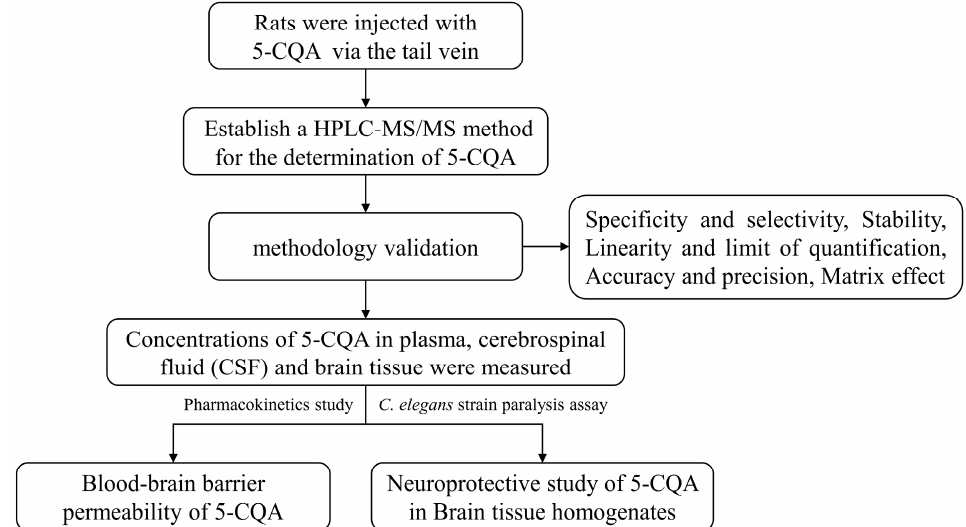
Figure 7. The graphical scheme of our study approach.